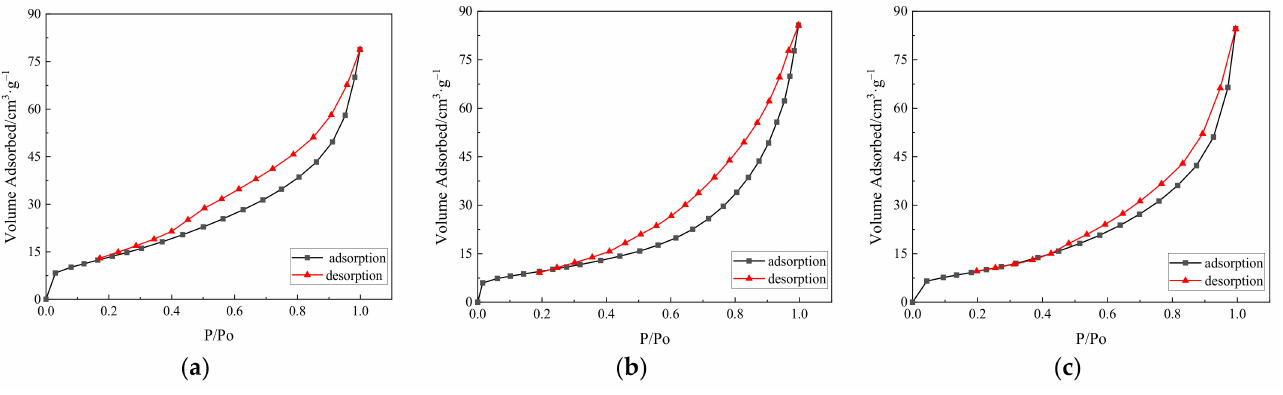
Figure 2. N 2 adsorption/desorption isotherms of catalysts: ( a ) Fe 0.8 Cu 0.2 /RHA; ( b ) Fe 0.67 Cu 0.33 /RHA; ( c ) Fe 0.5 Cu 0.5 /RHA.